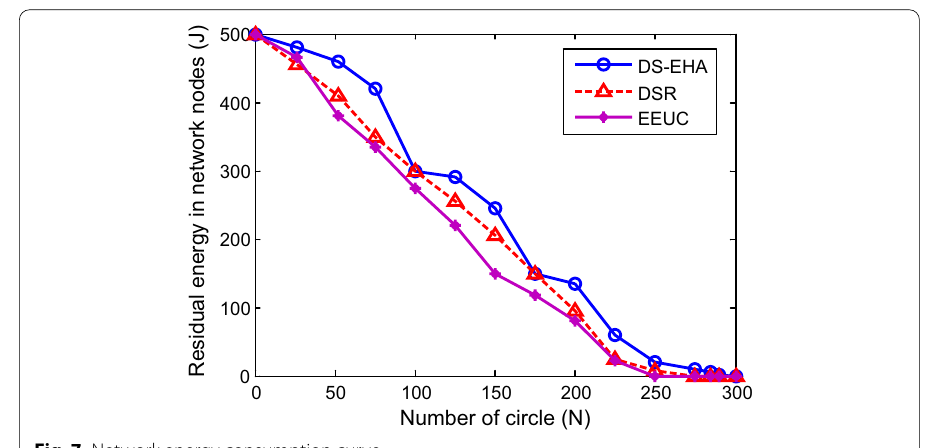
Fig. 7 Network energy consumption curve